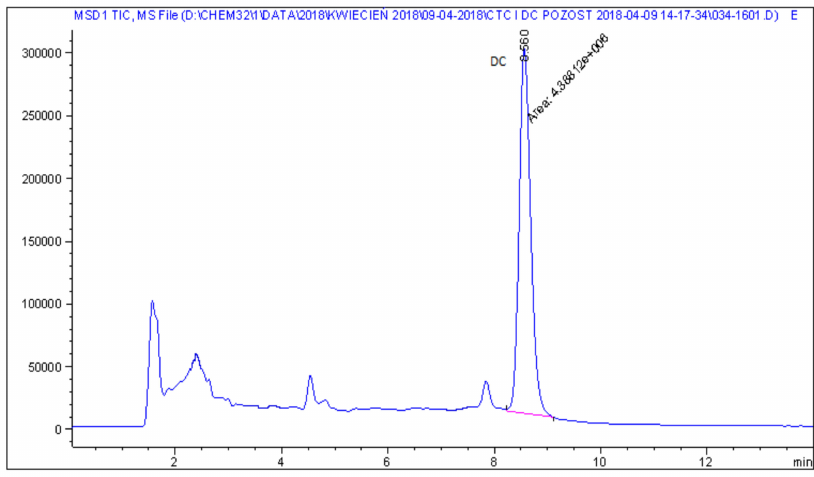
Figure 5. LC − MS chromatogram of real non-medicated feed sample with doxycycline at a concentration of 1.5 mg kg − 1